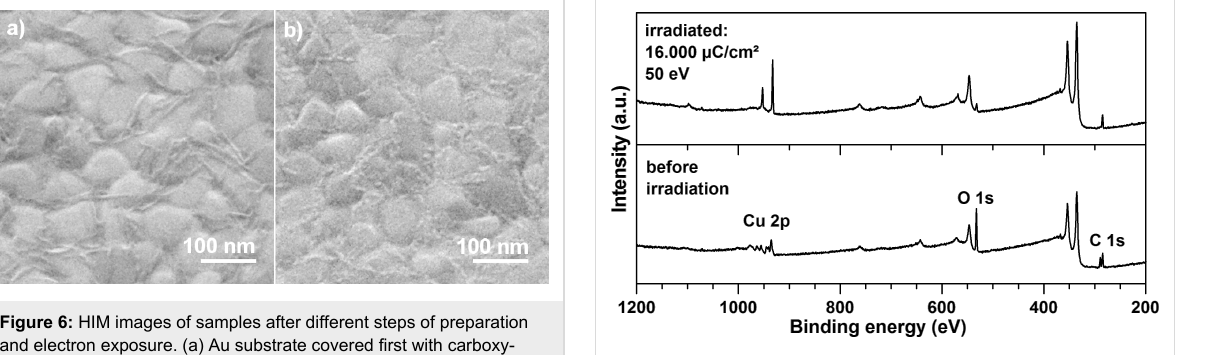
Figure 7: XP survey spectra recorded (a) before and (b) after an elec- tron exposure of 16000 μ C/cm 2 at 50 eV of surface-grown copper(II) oxalate prepared by performing four deposition cycles. The sample was grown on a MUA-coated gold